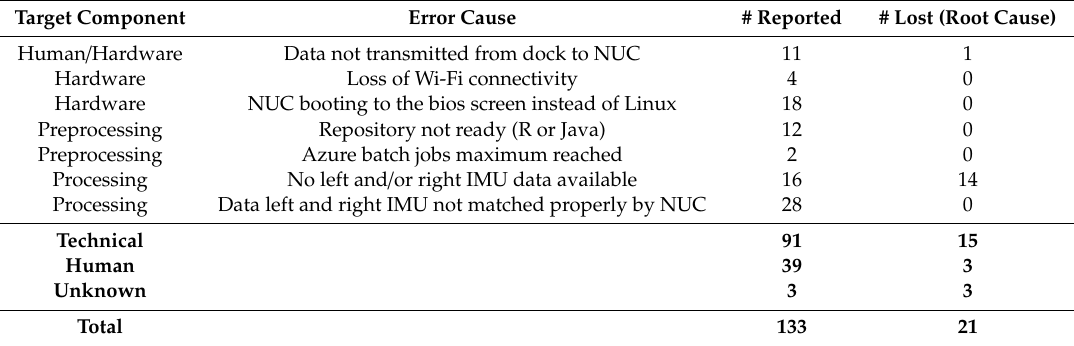
Table 2. Encountered technical errors and total number of reported human, technical, and unknown error causes including root causes related to lost measurement days.